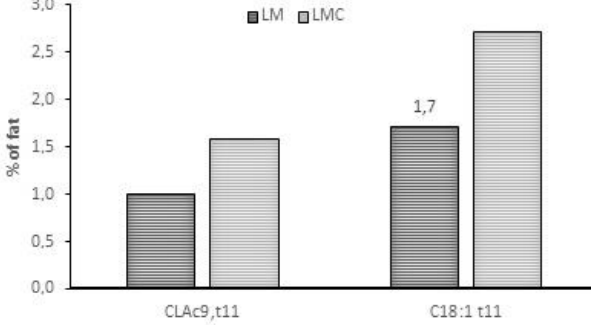
Figure 7. Level of CLA cis -9, trans -11 and vaccenic acid in milk from sheep fed with binary mixture (ryegrass + burr medic, LM) compared to ternary mixture (ryegrass + burr medic + Chrysanthemum coronarium , LMC), [42].